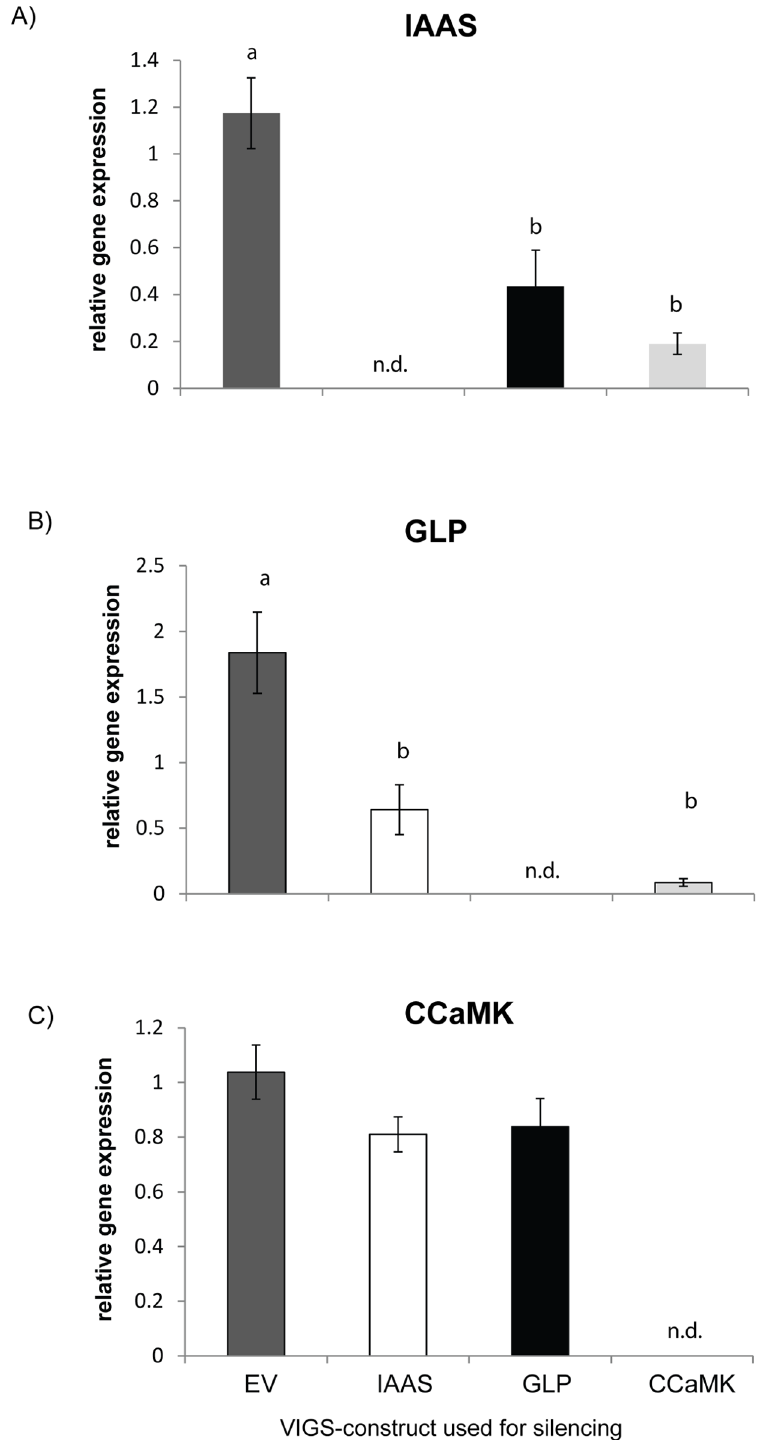
Fig 5. Transcript level of GH3 . 9 , GLP and CCaMK analyzed by qPCR in virus-infected control plants (EV) and GH3 . 9 , CCaMK and GLP -silenced plants. Plants were harvested 28 days after transfer to Rhizophagus irregularis inoculum, and relative transcript levels of A) GH3 . 9 ( putative indole-3-acetic acid- amido synthetase GH 3 . 9 ), B) GLP ( germin-like protein ) and C) CCaMK ( calcium and calmodulin dependent protein kinase ) in roots of the virus-inoculated plants carrying the different constructs were